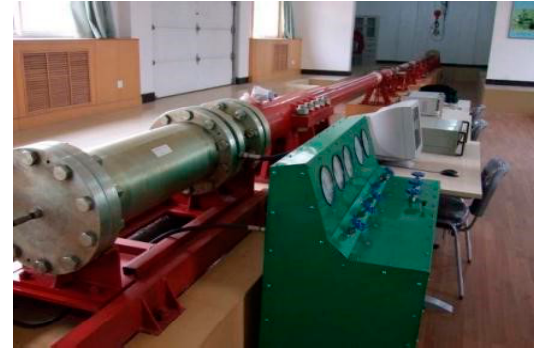
Figure 3. Φ 100 mm SHPB test system.